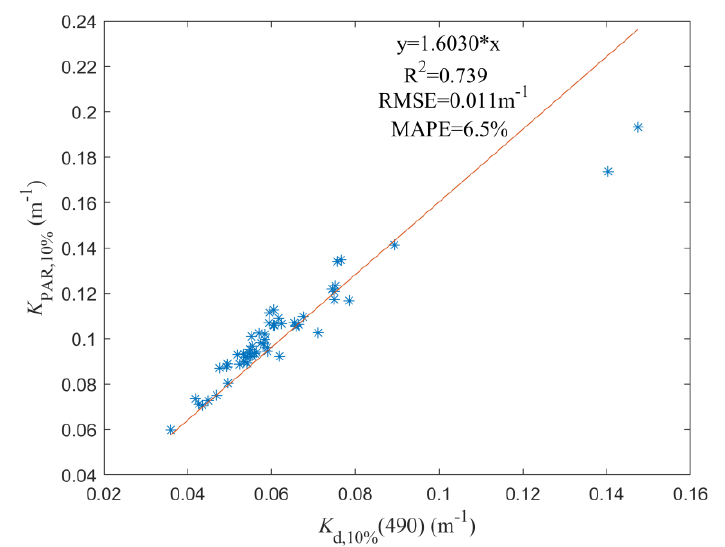
Figure 11. Relationship between K PAR ,10% and K d .10% ( 490 ) . The Z SDD results obtained with Equation (12) ranged from 5 to 23 m, with an average of approximately 14 m. In particular, the values of Z SDD at three stations (B1, B2, and Q18) in 2013, which are nearest to the shore, were less than 10 m, and the value of Z SDD at station S29 in 2015 was greater than 20 m. In order to illustrate the spatial schematic diagram of Z SDD in the investigation area, ODV was also used the same as in Figures 5–7, and the Weighted-average gridding method was used to interpolate the station values. The result is shown in Figure